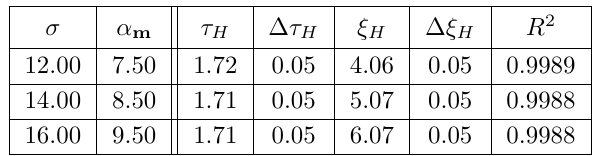
( t ) = − t + ξ for t ∈ [2 , 4] for κ = 1 . 5 in zero bath. H 0 τ H